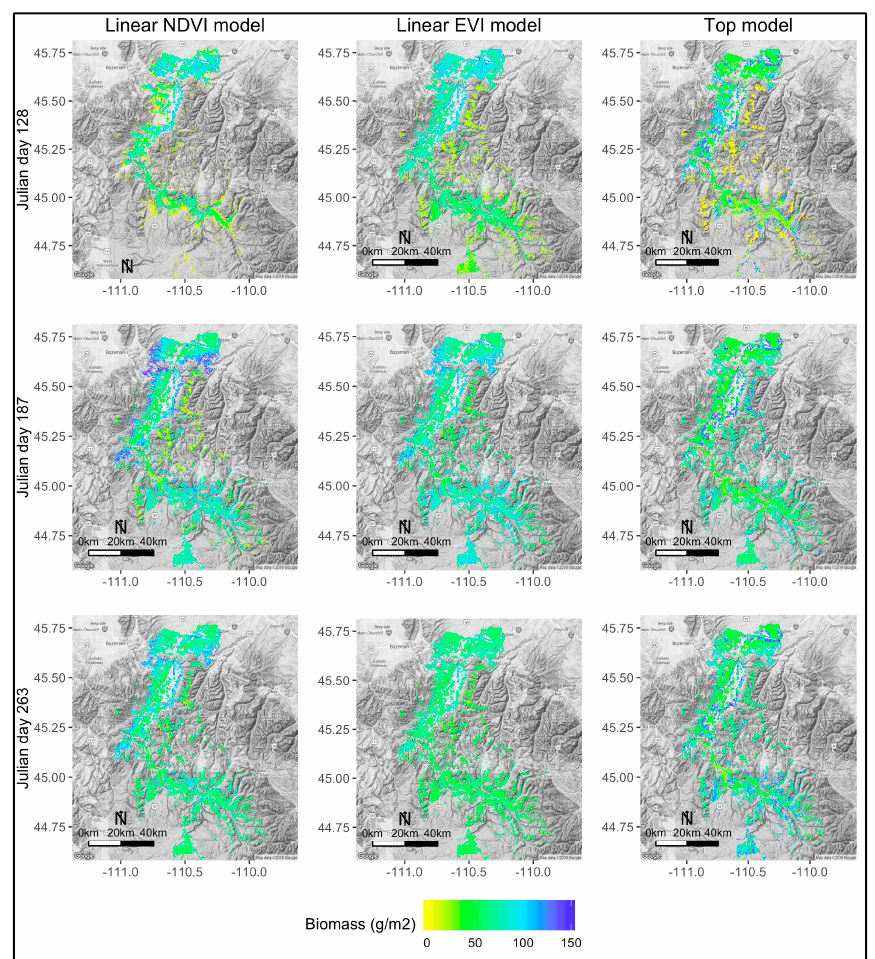
Figure 5. Maps of the aboveground biomass (g/m 2 ) of grasslands across the Upper Yellowstone River Basin on Julian days 128, 187, and 263 estimated from the linear NDVI, linear EVI, and the top models.